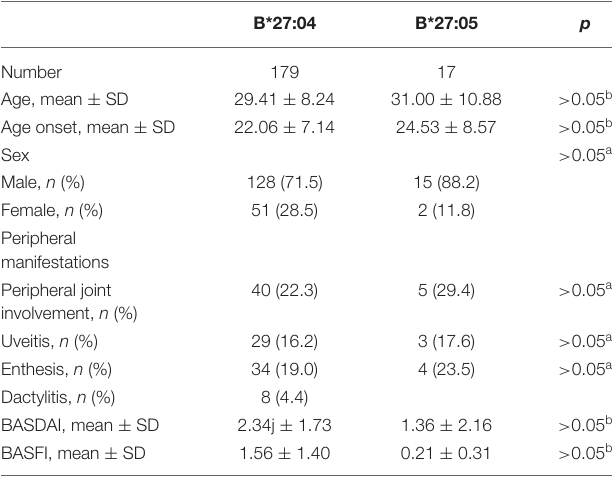
TABLE 4 | Disease characteristics of B * 27:04 and B * 27:05 AS patients (step 2).